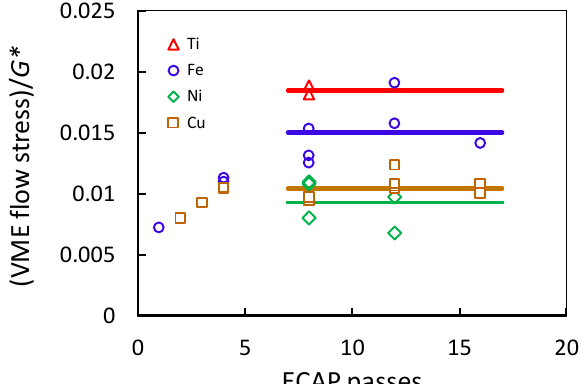
Figure 6. VME flow stress data (ultimate tensile strength, UTS or a third of the Vickers hardness, HV / 3) of fcc 99.95% Cu [30–35] and 99.98% Ni [36–39], body-centered cubic (bcc) 99.95% Fe [40–44] and hcp 99.5% (grade 1) Ti [45,46] as a function of the number of equal-channel angular pressing (ECAP) passes performed at 300 K (one pass imparts about one unit of VME strain). Dotted lines are the average of values of flow stress between 8 and 16 passes for each metal; an apparent saturation stress is reached at 300 K beyond 7 ECAP passes for at least Cu, Ni, and Fe.